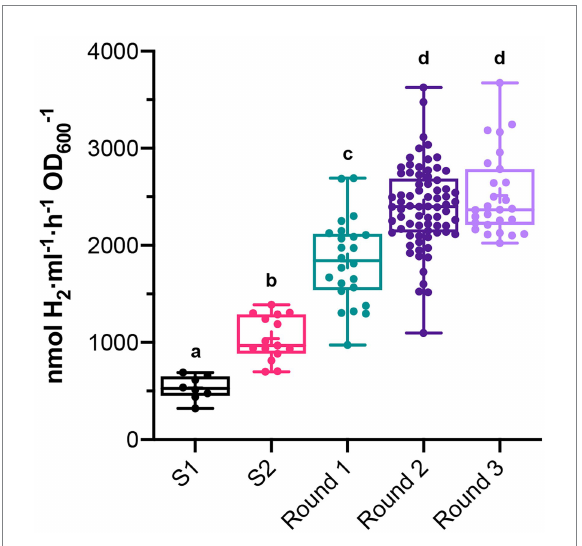
β -galactosidase activity in previous MUG assays. Measurements were taken after each round of UV mutagenesis. In vivo H 2 production of S1 and S2 are shown as reference. Boxes show 25th to 75th percentiles, the median (line), and the mean (+). Whiskers show from minimum to maximum values. Each dot represents H 2 production of a different clone. Different letters indicate statistically significant differences ( p < 0.05 for S1 vs. S2, and p < 0.0001 for the rest of group